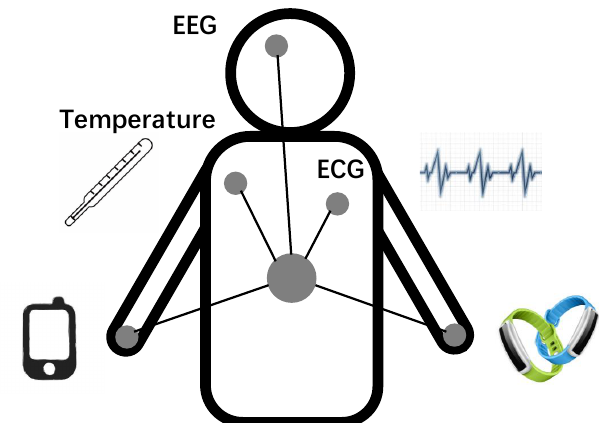
Figure 1. Illustration of wireless body area network (WBAN) application. EEG = electroencephalograph; ECG =